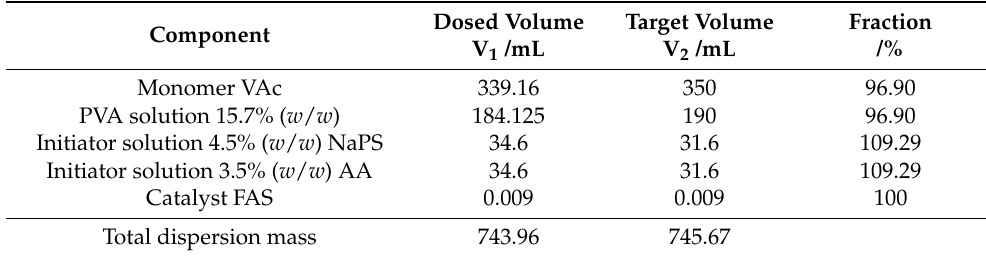
Table 2. Final composition of the dispersion P Polyvinyl acetate (PVAc)_1wr with 36.3 g L − 1 PVA dissolved in 151.2 g of water in the initial charge after abortion of the dosing of monomer and PVA